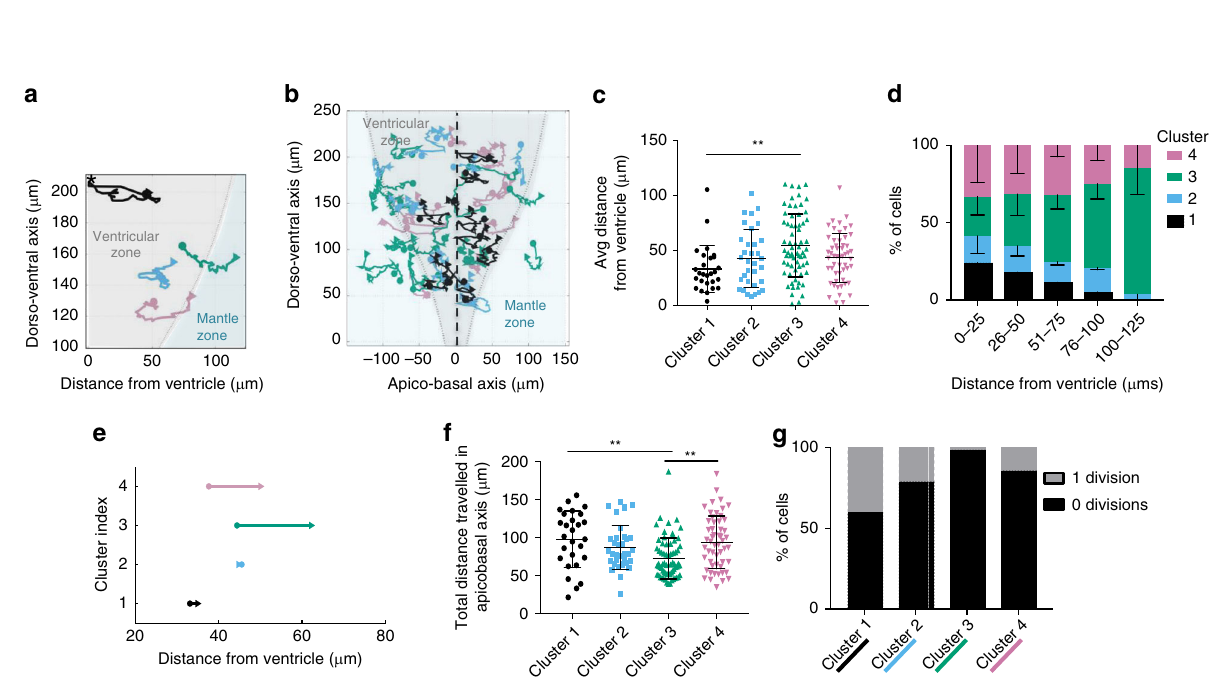
Fig. 3 Single cell Venus::HES5 dynamics correlate with cell state. a Example single cell tracks for each cluster from 1 representative experiment. ‘ * ’ denotes cell division. Dorso-ventral axis in μ m from fl oorplate. b Single cell tracks ( n = 54) over 12-h in a single E10.5 spinal cord slice movie. Black dotted line — ventricle. Grey — ventricular zone and green — mantle zone measured by Sox2/NeuN immunostaining of two ex vivo slices. c Average distance of single cell from ventricle over 12-h track. Cells from three experiments clustered separately. Kruskall – Wallis with Dunn ’ s multiple comparisons test indicated cluster 1 vs. 3 adjusted p -value = 0.0014 (**). d Percentage of any cells found in 25 μ m windows from ventricle in each cluster. Two-way ANOVA with Tukey multiple comparison test shows no difference between clusters <50 μ m from ventricle. 76 – 100 μ m from ventricle cluster 3 vs. 1 p < 0.0001, 3 vs. 2 p = 0.0009, 3 vs. 4 p = 0.014. e Displacement of cells in each cluster. Dot — average start position, arrow — average fi nish position. f Total distance travelled of single cells. Line is mean with SD. Kruskal – Wallis test with Dunn ’ s multiple comparison test shows cluster 1 vs. 3 adjusted p = 0.003 (**), cluster 3 vs. 4 adjusted p = 0.0017 (**). g Percentage of cells per cluster undergoing 0 or 1 divisions in 12 h. Chi-squared test of frequency data p = 0.0002. 181 cells, three experiments clustered separately. Cluster 1 — black ( n = 27 cells), cluster 2 — sky blue ( n = 33 cells), cluster 3 — green ( n = 67 cells), cluster 4 — pink ( n = 54 cells). Error bars — SD. Source data are provided in a Source Data fi le